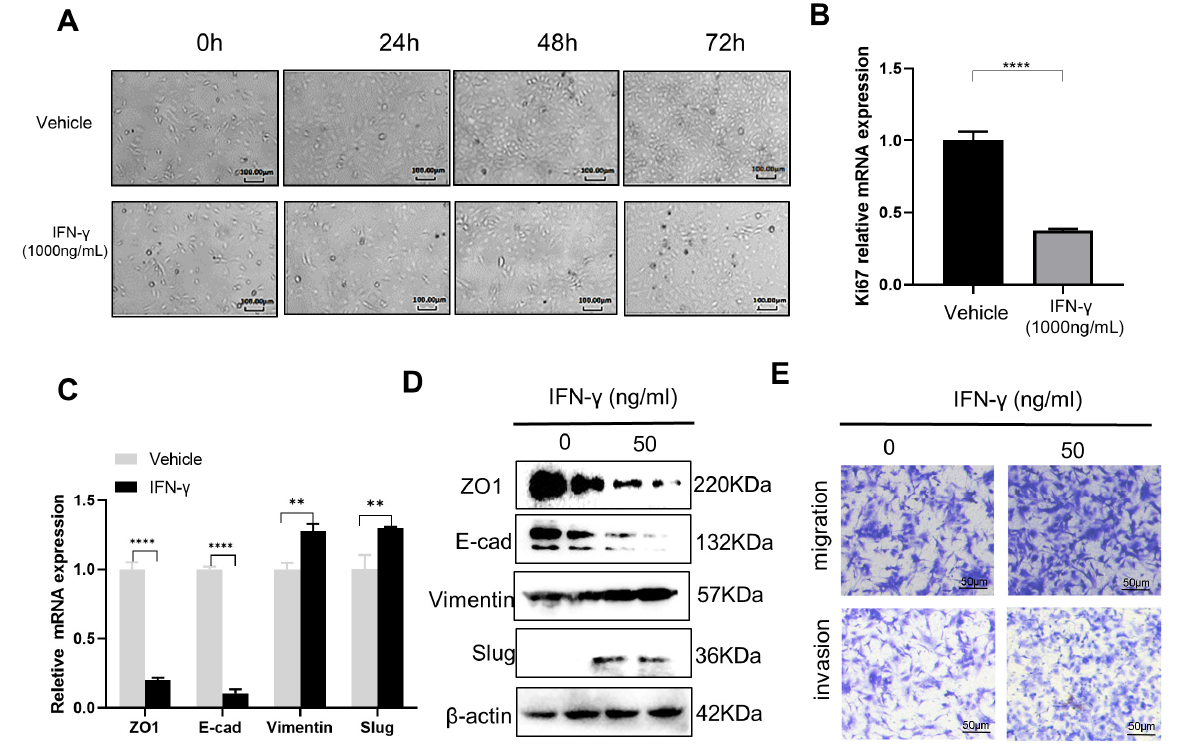
Figure 1. High-dose IFN- γ inhibits cancer growth, while low-dose IFN- γ promotes metastasis in SKOV3 cells in vitro. ( A ) Microscopic observation of the effect of high-level (1000 ng/mL) IFN- γ on cell proliferation of the OC cell line SKOV3. The control cells were treated with vehicle. ( B ) Real-time qPCR to examine the expression of Ki67 mRNA after the SKOV3 cells were treated with vehicle or high-level (1000 ng/mL) IFN- γ for 72 h. ( C ) Real-time qPCR examination of EMT markers after the SKOV3 cells were treated with low-level (50 ng/mL) IFN- γ or vehicle for 48 h. ( D ) Western blotting examination of EMT markers after the SKOV3 cells were treated with low-level (50 ng/mL) IFN- γ or vehicle for 48 h. ( E ) Transwell assays to examine the effect of low-level (50 ng/mL) IFN- γ on the migration and invasion properties of SKOV3 cells. Data are represented as mean ± standard deviation (SD), n = 3. ** p < 0.01, **** p < 0.0001.